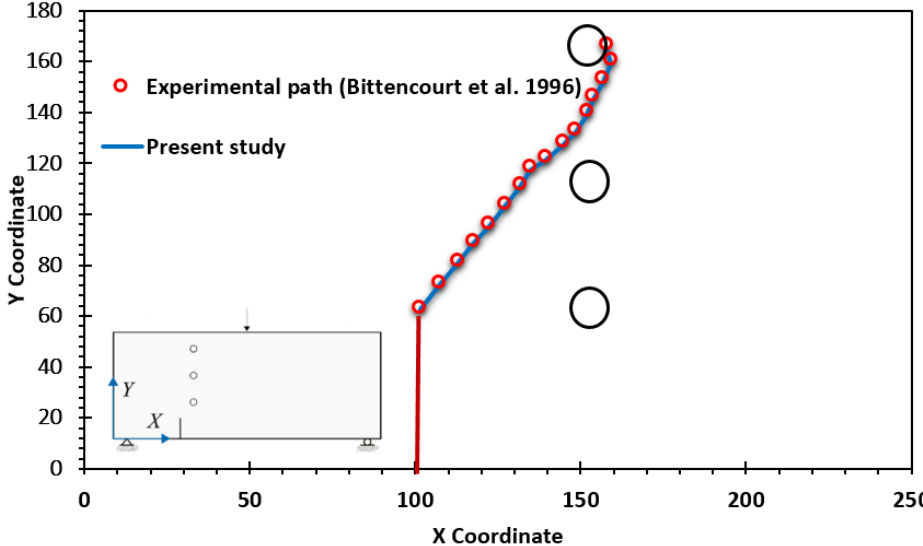
Figure 16. Crack tip coordinates comparison for specimen 5.